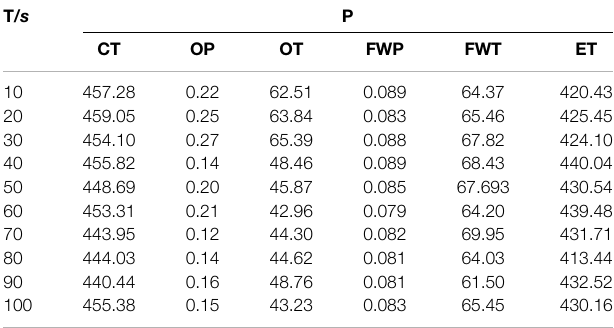
TABLE 3 | Collected data of engine equipment from normal operation to fault 1.